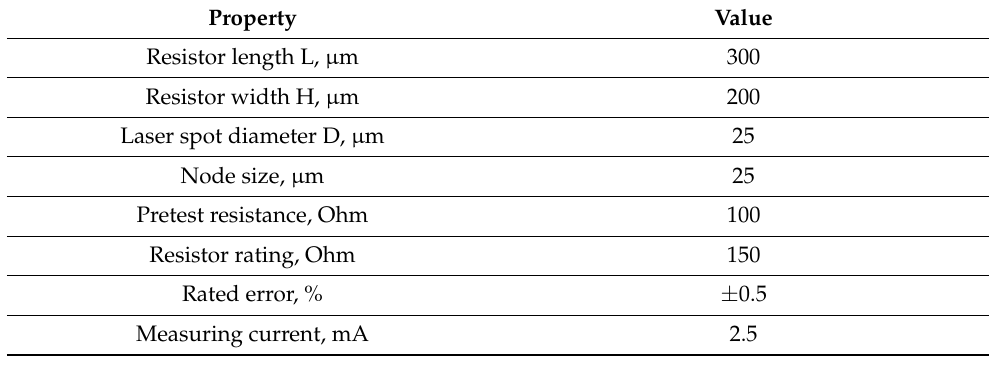
Table 3. Input data for trim simulation.